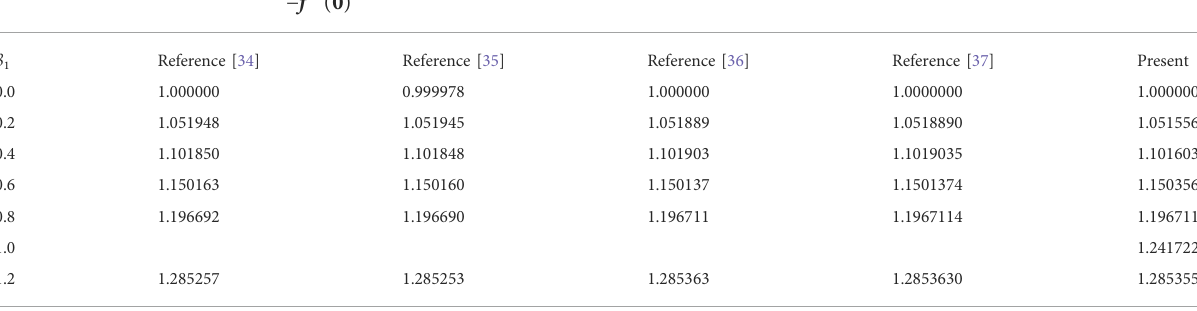
99 ( 0 ) for M ≥ 0 when α = β 1 =